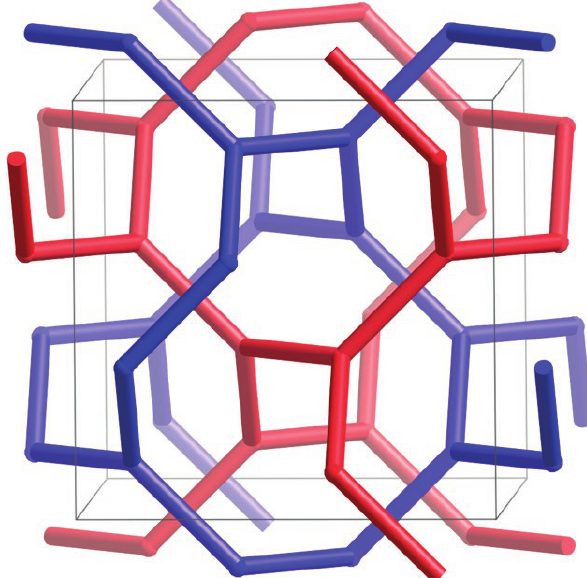
Figure 10. LUZZATI and SPEGT’S model (1967) of the mesostruc- ture of a cubic phase, consisting of two intertwined rod networks, enclosing water (reversed phases) or the lipid/surfactant chains (normal phases).